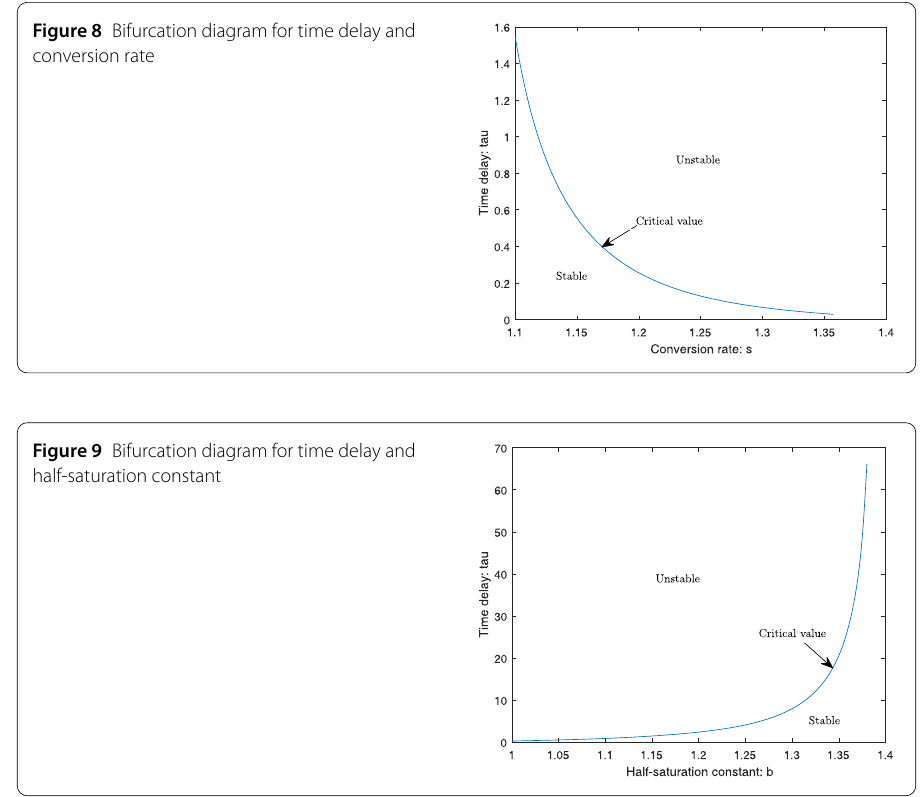
Figure 8 Bifurcation diagram for time delay and conversion rate